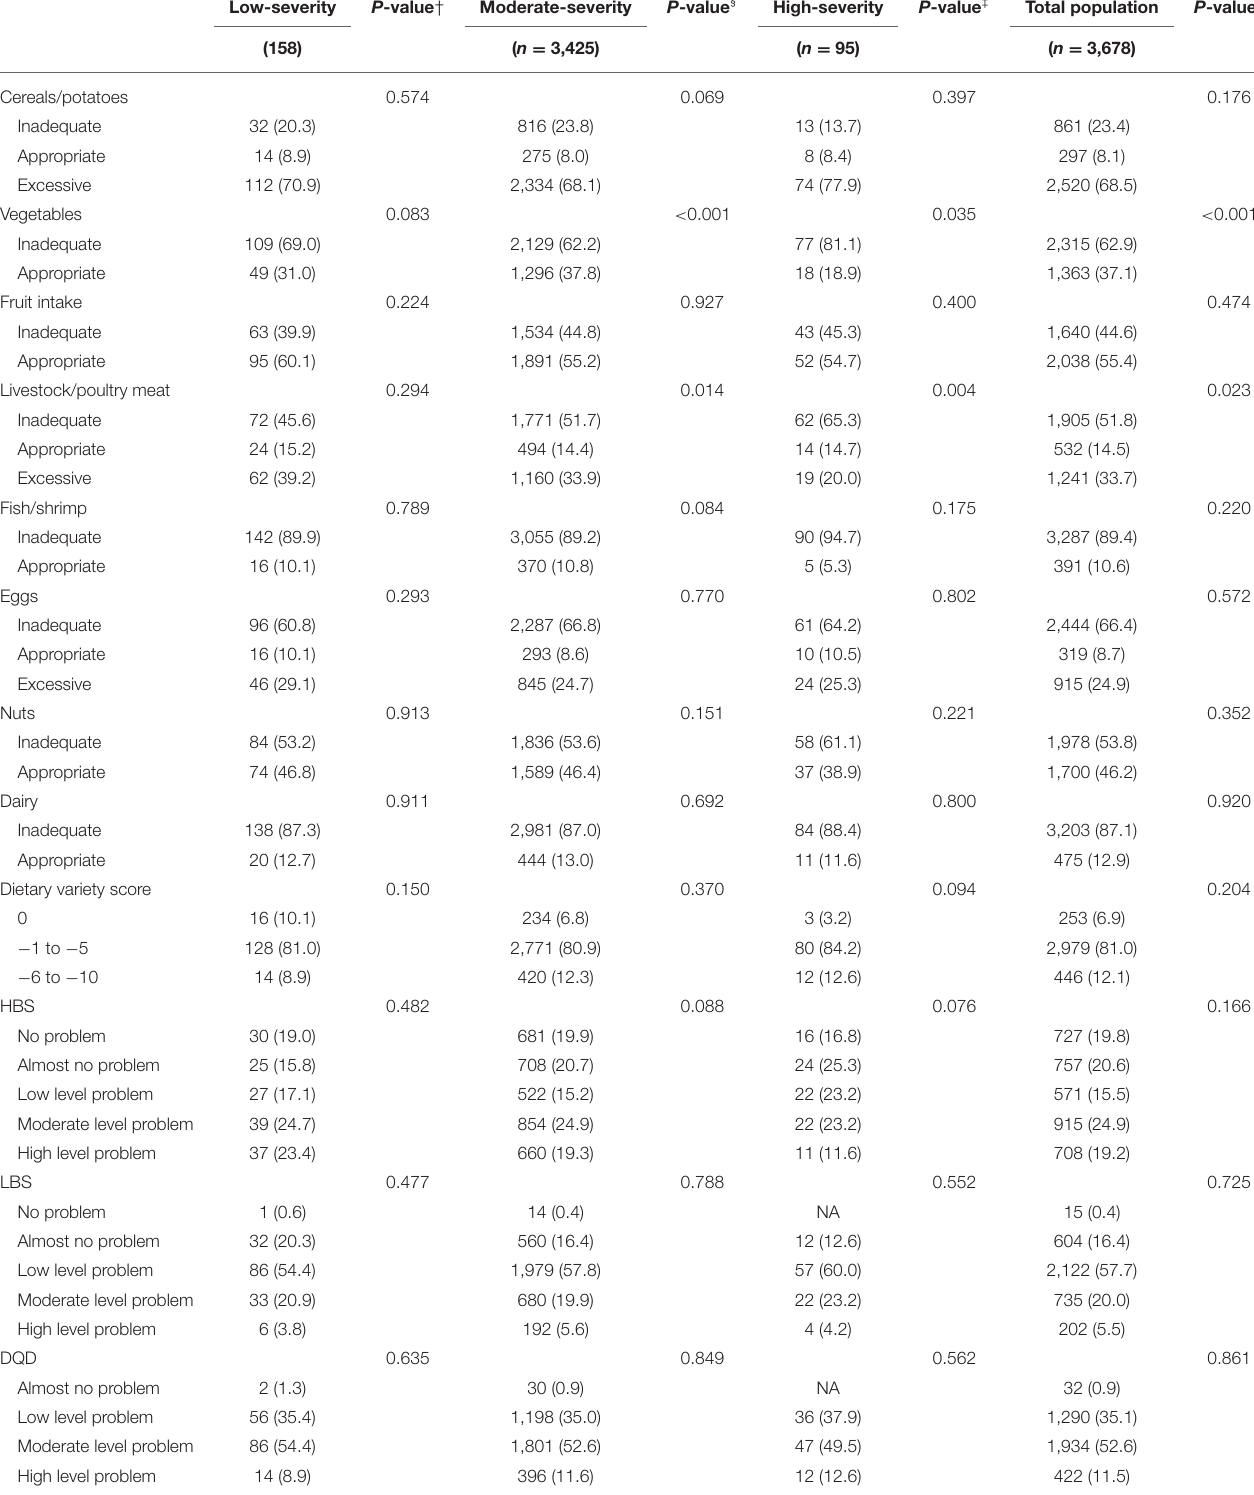
TABLE 2 | Distribution of food intake and diet quality (DBI) for pregnant women according to COVID-19 pandemic